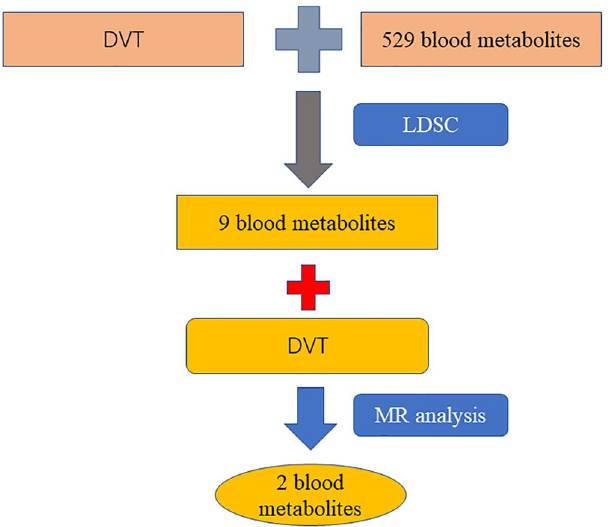
Figure 1. Detailed flowchart of the result. We analyzed the genetic correlation between DVT and 529 blood metabolites by LDSC, and found that 9 blood metabolites may had genetic correlation with DVT. Then the causal relationship between these 9 blood metabolites and DVT was analyzed by MR, and it was found that 2 blood metabolites had causal correlation with